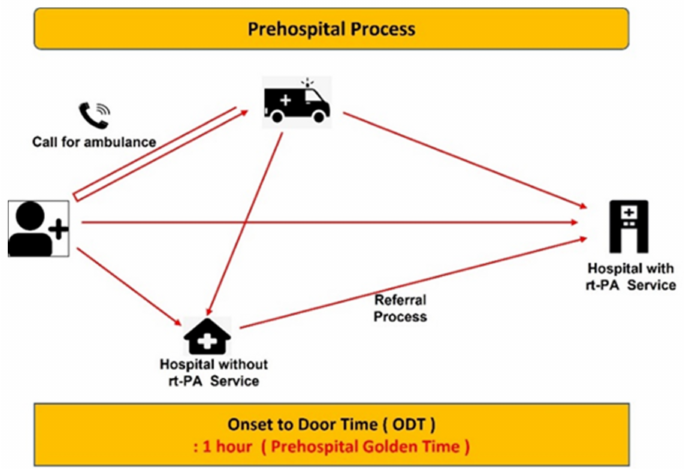
Figure 7. Model of the prehospital stroke